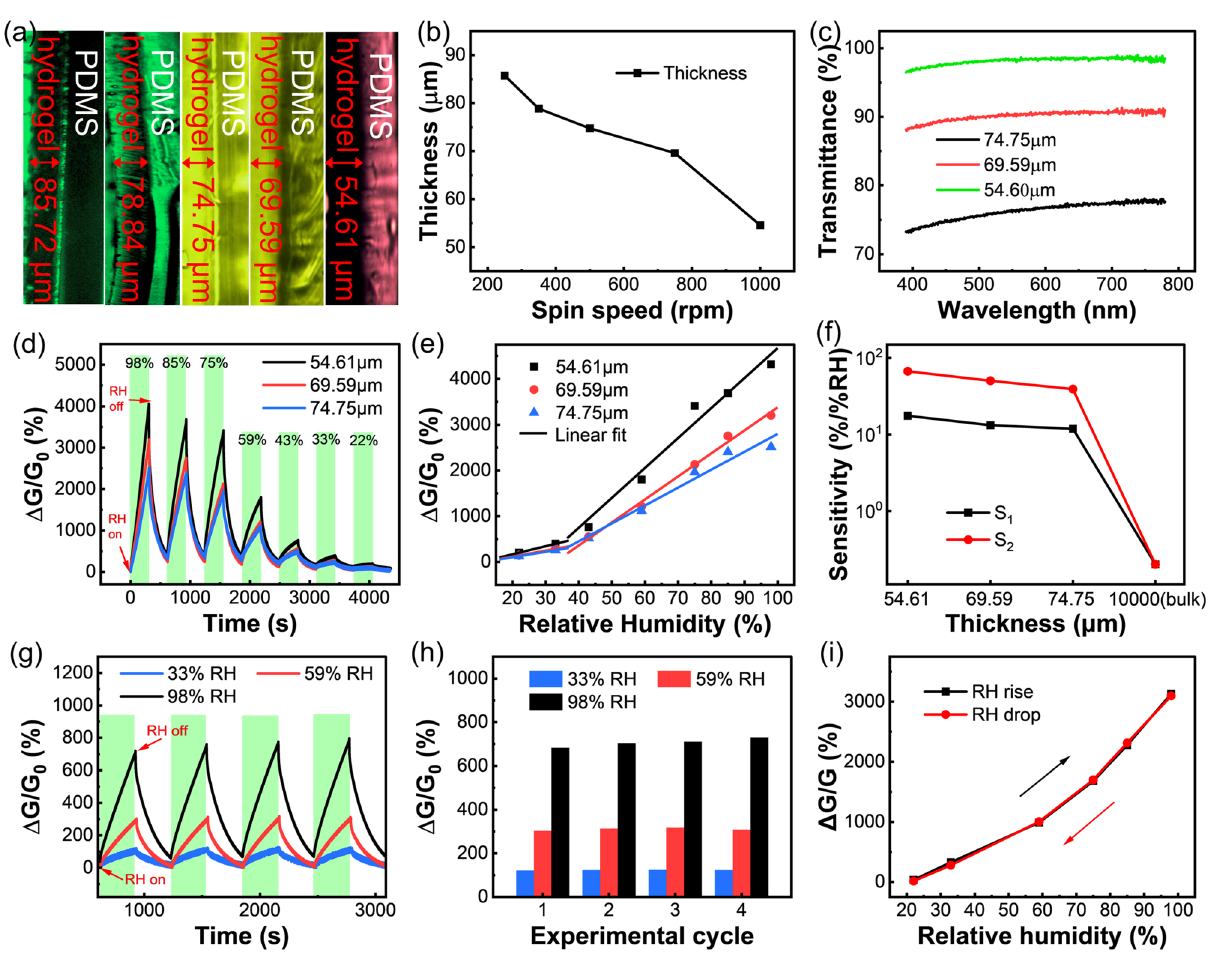
Fig. 4 a Cross-sectional Optical microscope images showing the PDMS substrates and hydrogel films with different thicknesses obtained using different spin-coating speeds. b The correlation between spin coating speed and the thickness of hydrogel films. c Transmittance of film hydro- gels with different thickness in the visible wavelength range. d Time-dependent responses of the humidity sensors with different film thickness upon exposure to different RH. e Piecewise fitting of the response of sensors with different film thicknesses versus RH. f The dependences of sensitivities (S 1 under 11–37% RH and S 2 under 37–98% RH) on the thickness of the film. g Time-dependent and repeated response of the sen- sor to 33, 59, and 98% RH in four experimental cycles, respectively. h Quantitative responses extracted from g versus experimental cycle for dif- ferent RH. i Hysteresis curve of the